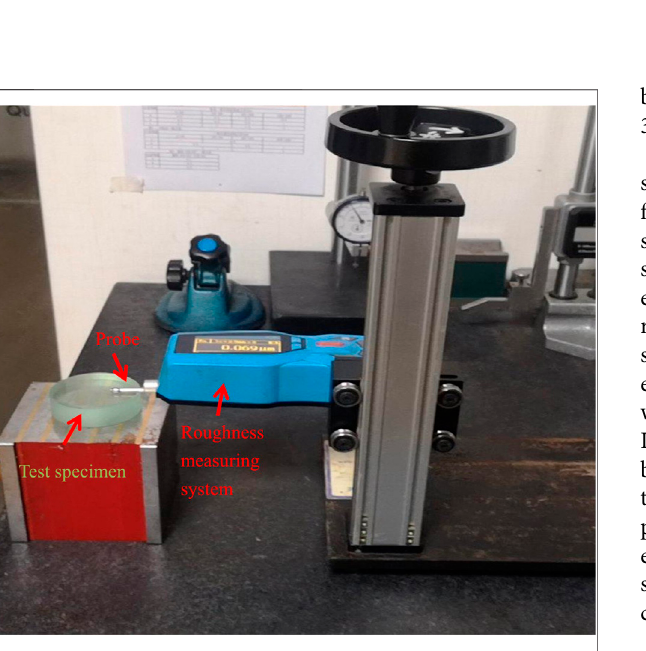
Frontiers in Earth Science |